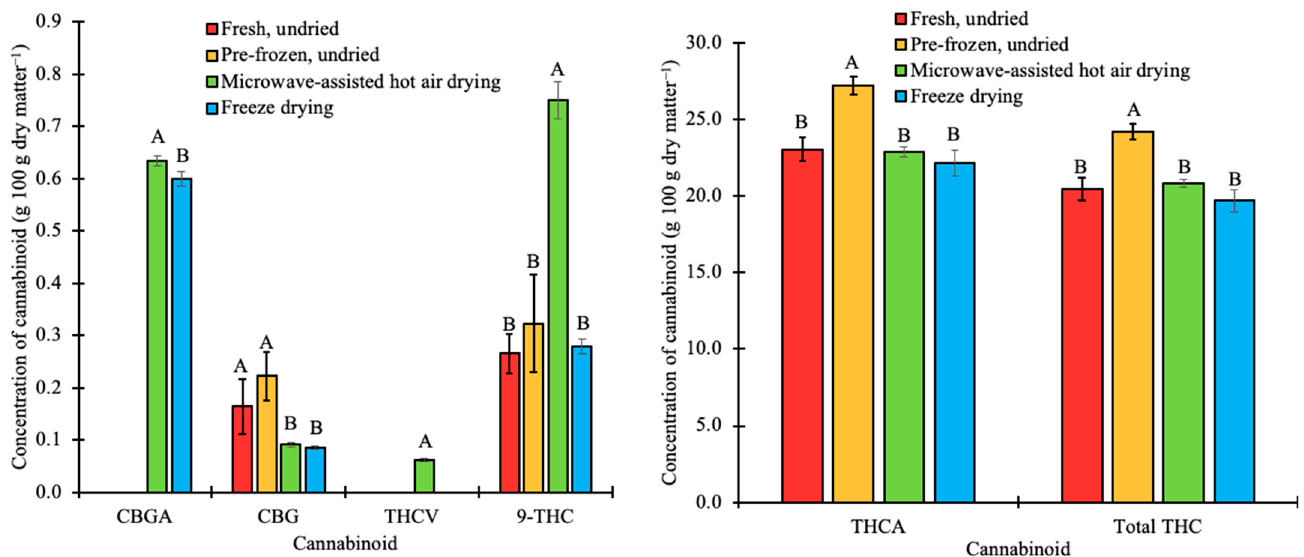
Figure 4. Concentration of cannabinoids in pre-frozen undried, microwave-assisted hot air dried, and freeze dried-cannabis ( C. sativa ) biomass. Bars with the same letter are not significantly ( p < 0.05) different.